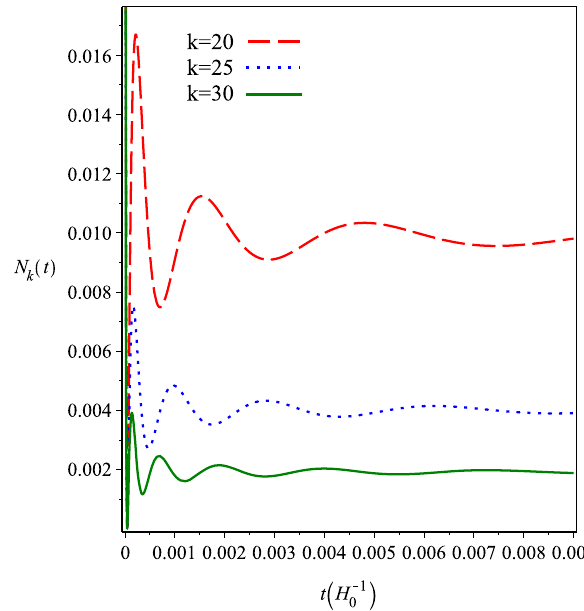
Fig. 3 Evolution of the density of massless created particles N k versus the physical time t (in units of H − 1 ) for three different values of the 0 mode k with the parameter m = 2 /